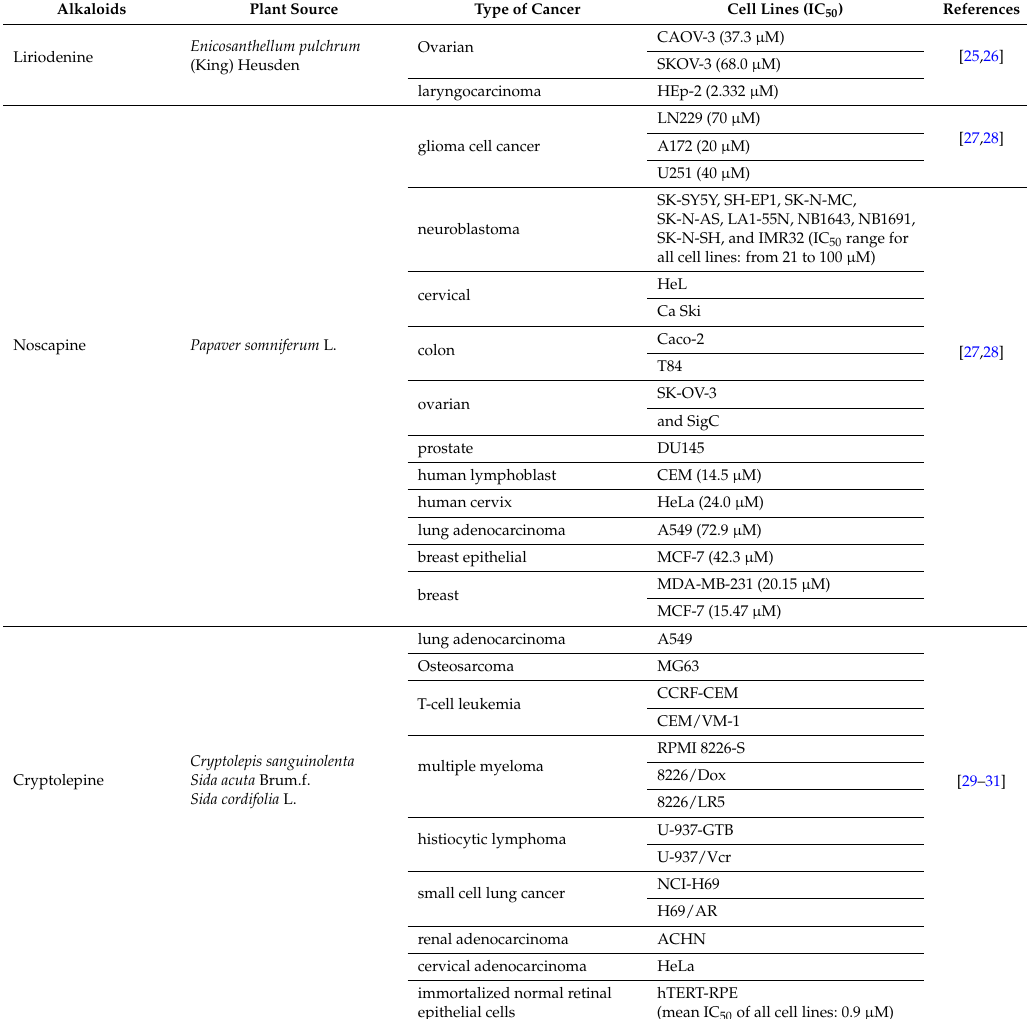
Table 1. Activity of newly emerging anti-neoplastic plant-derived alkaloids on cancer cell lines.